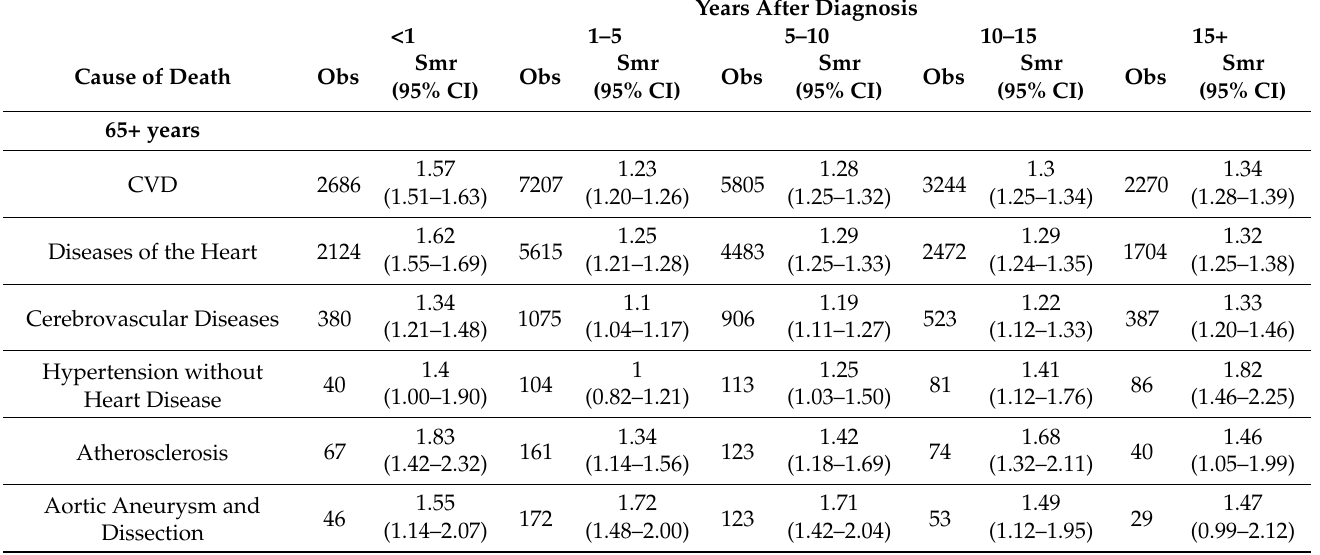
Table 2. Standardized mortality ratios for cardiovascular death in elderly patients with bladder cancer based on years after diagnosis.